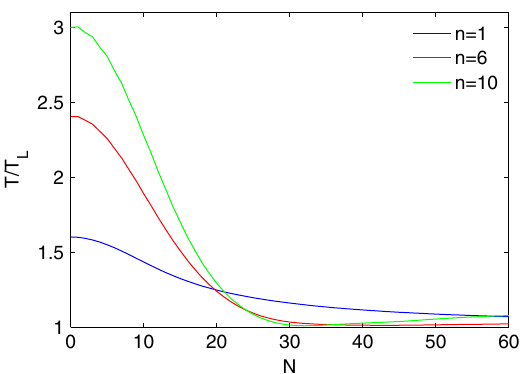
FIG. 4. Energy modulation amplitude and corresponding local bunching factor distributions along the electron beam for differ- ent harmonics of the seed ( n ¼ 1 , 6, and 10).